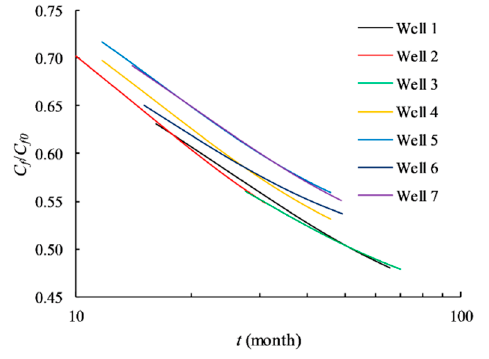
Figure 7. Variation of fracture conductivity with production time for different wells.